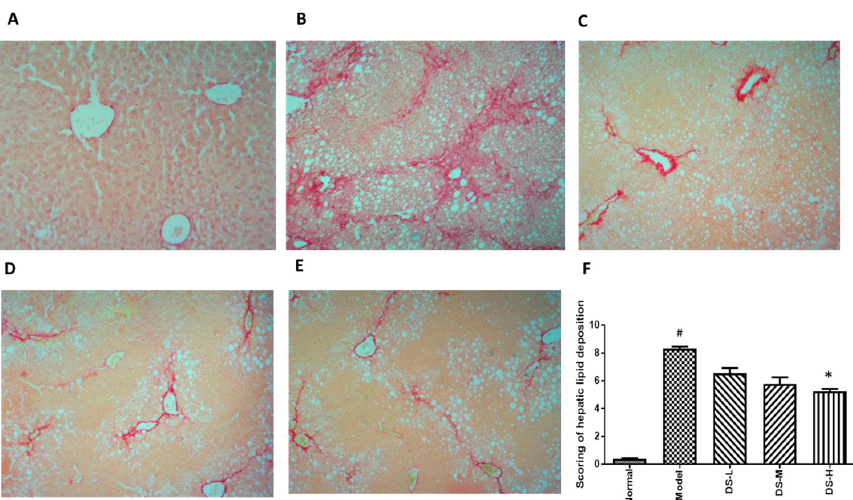
Figure 7. Picrosirius red staining results after Danshen treatment in NAFLD (original magnification 100 × ). Treatment with Danshen attenuated the collagen deposition in NAFLD. ( A ) The normal group showed little collagen deposition within hepatocytes; ( B ) in the model group, PSR staining showed significant collagen deposition level within hepatocytes; ( C – E ) treatment with Danshen (0.093, 0.28, 0.84 g/kg) for six weeks significantly reduced collagen deposition levels in the liver; ( F ) scoring of collagen deposition of NAFLD mice with Danshen treatment (Mean ± SD). DS-L for low dose of Danshen treatment group (0.093 g/kg); DS-M for middle dose of Danshen treatment group (0.28 g/kg); DS-H for high dose of Danshen treatment group (0.84 g/kg). # p < 0.05, compared with Normal group * p < 0.05 when compared with model group.